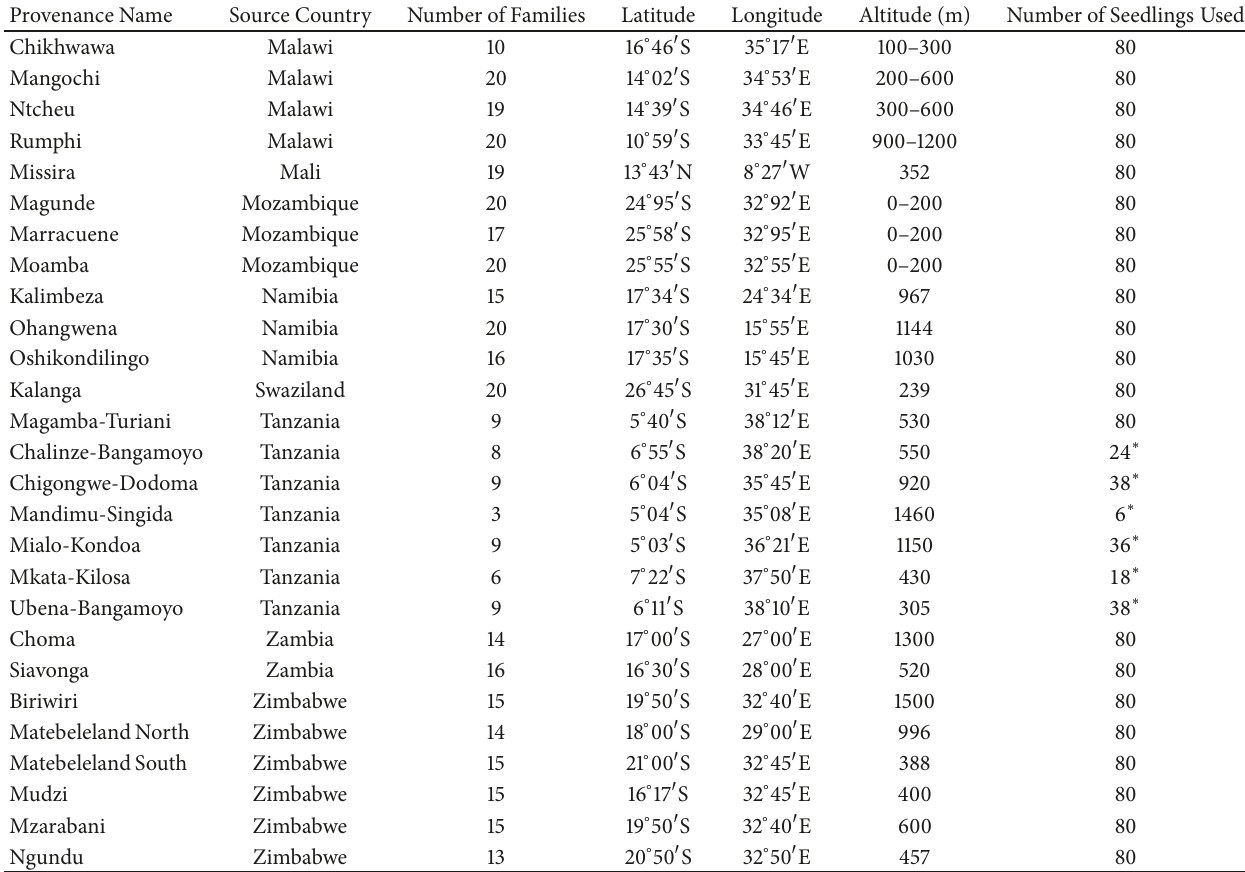
Table 1: Characteristics of the mating system